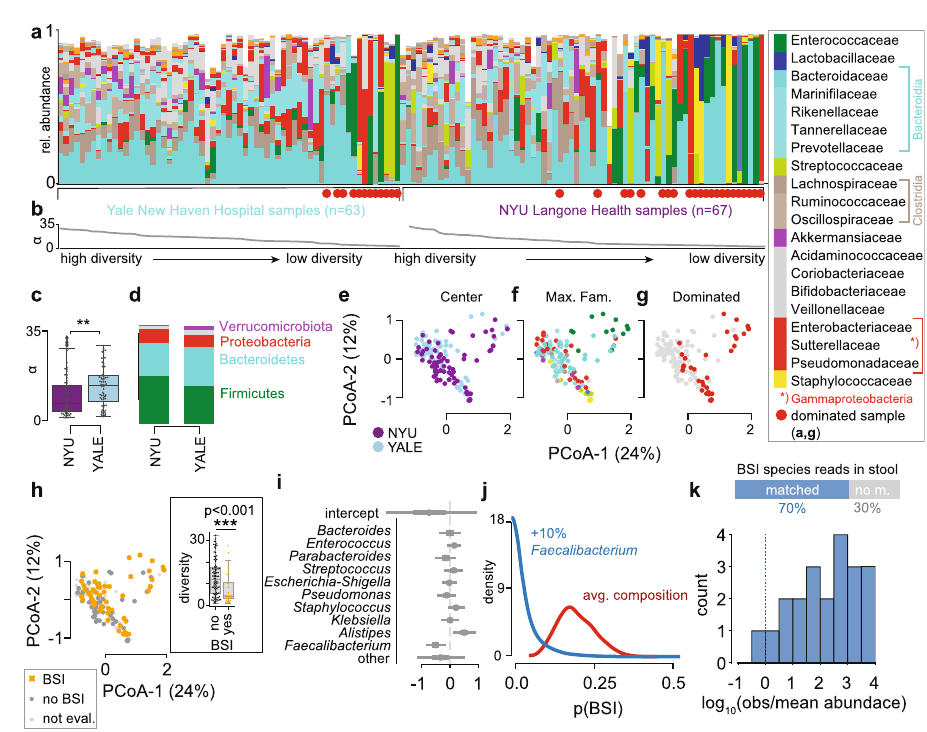
Fig. 3 | The dysbiotic gut microbiome in COVID-19 in patients from NYU Lan- gone Health ( n =60) and Yale New Haven Hospital ( n =36) is associated with secondary bloodstream infections. a Bacterial family composition in stool sam- ples (Yale, n =63 samples; NYU, n =67) identi fi ed by 16S rRNA gene sequencing; bars represent the relative abundances of bacterial families; red circles indicate samples with single taxa >50%. Samples are sorted by center and bacterial α - diversity (inverse Simpson index, b ). c α -diversity in samples from NYU Langone Health and Yale New Haven Hospital; p =0.0065, two-sided T-test. d Average phylum level composition per center. Principal coordinate plots of all